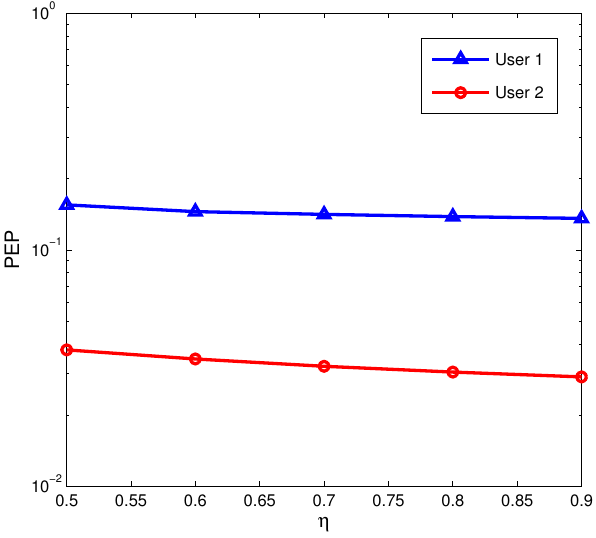
Figure 6. PEP vs. η for both